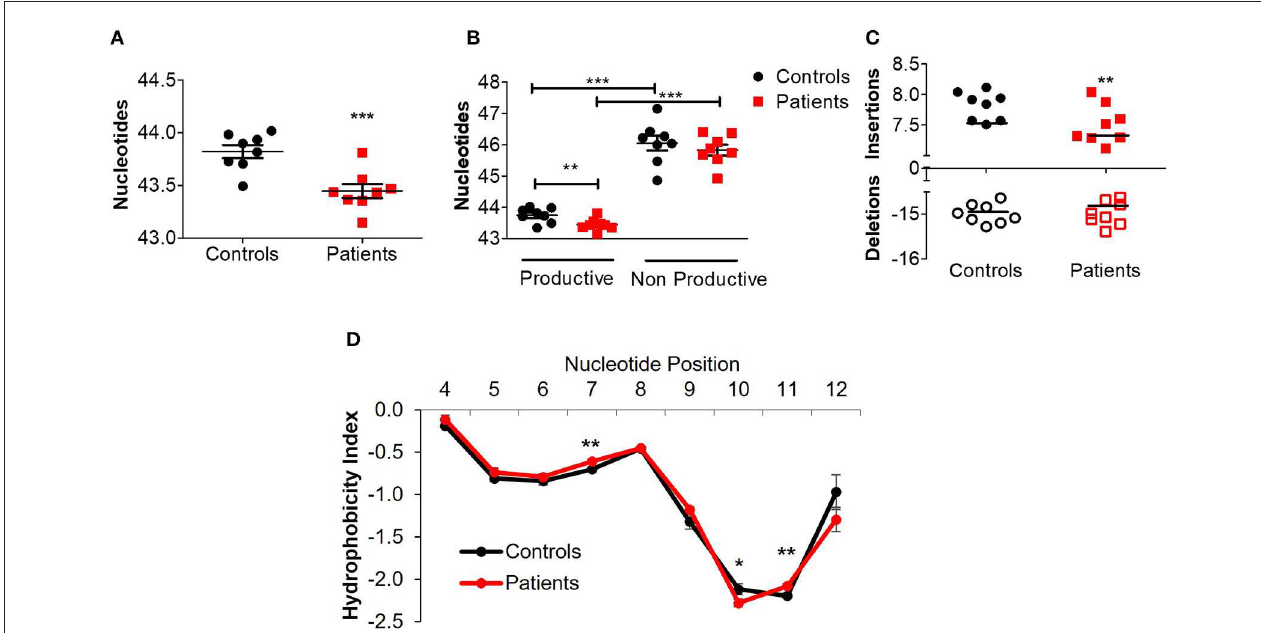
FIGURE 3 | Aberrant TCR β length and hydrophobicity in T cell lymphocytes of patients with IL10/IL10R defects. (A) Mean CDR3 β length in circulating lymphocytes of controls and patients. (B) Sub-analysis of CDR3 β length according to productive and non-productive clones. (C) Analysis of the number of nucleotide insertions and deletions in total clones. (D) Hydrophobicity index of the CDR3 β region. Position signifies successive amino acid location at the CDR3 β region. Bars represent mean ± SEM. P ≤ 0.001; Figure 7B ). Looking at the nucleotide level,